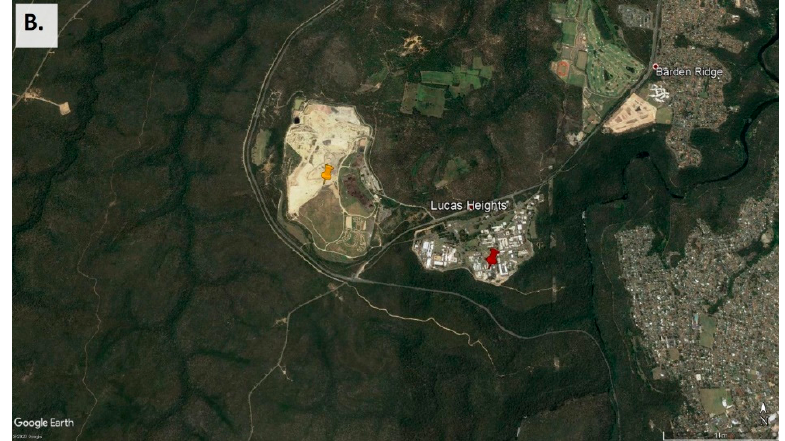
Figure 1. ( A ) Map of the sampling site location within its regional context in the southeast of Australia, showing ~100 km around the sampling point [48]. ( B ) Close-up view of the sampling site (red indicator) and its surroundings [49]. The yellow indicator shows the location of the Lucas Heights waste management facilities. Forest surrounds most of the area. There are residential areas close by to the east and further away to the west.